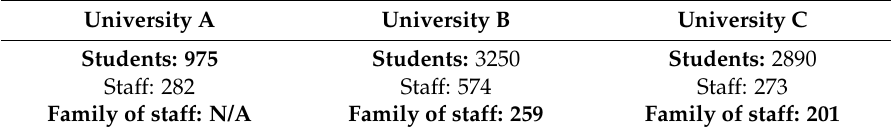
Table 1. Number of university students, staff, and family members at each gym.